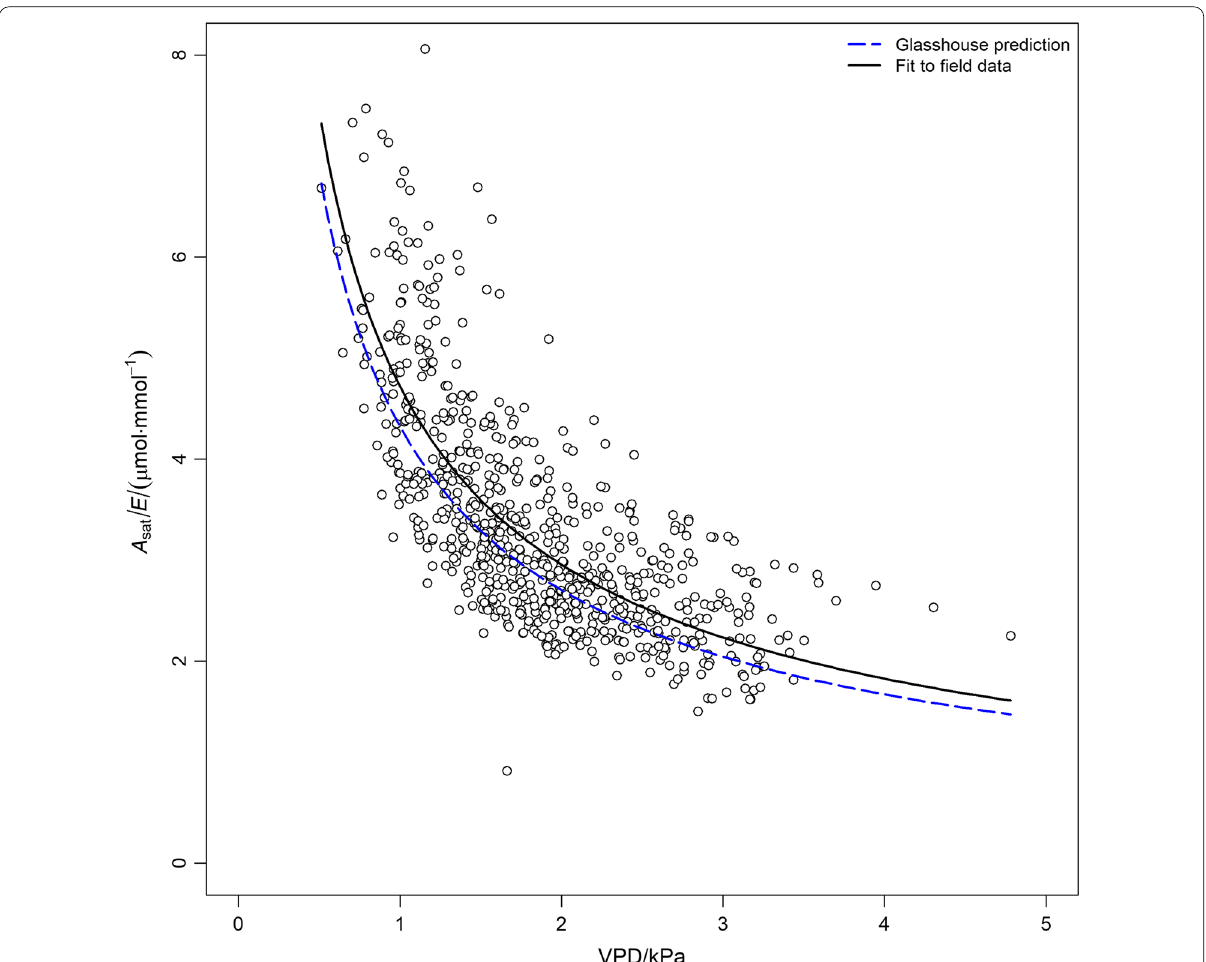
Fig. 3 A sat / E response to VPD of “well-watered” field-grown cotton. Black solid line represents model fit using g 1 and k estimates from field data. Blue dashed line represents g 1 and k model prediction based on cotton grown in the